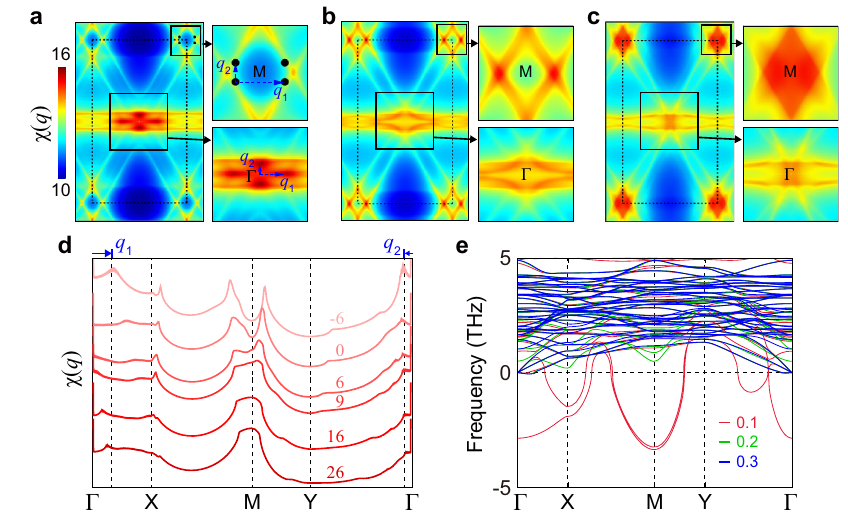
Fig. 3 | Electronic susceptibility and phonon bands of the A V 3 Sb 5 monolayer. a – c Electronic susceptibility χ ( q ) is calculated in 2D q -space for a the type-II VHS fi lling( μ = − 6meV), b neutral fi lling( μ =0meV),and c type-IVHS fi lling( μ =9meV). Therightpanelsshowamagni fi edviewoftheboxedareasoftheleftpanelnearthe high-symmetric Γ and M points, respectively. q 1 and q 2 in a represent the nesting vectors that connect the type-II VHS points (black circles). d Line pro fi les of χ ( q )